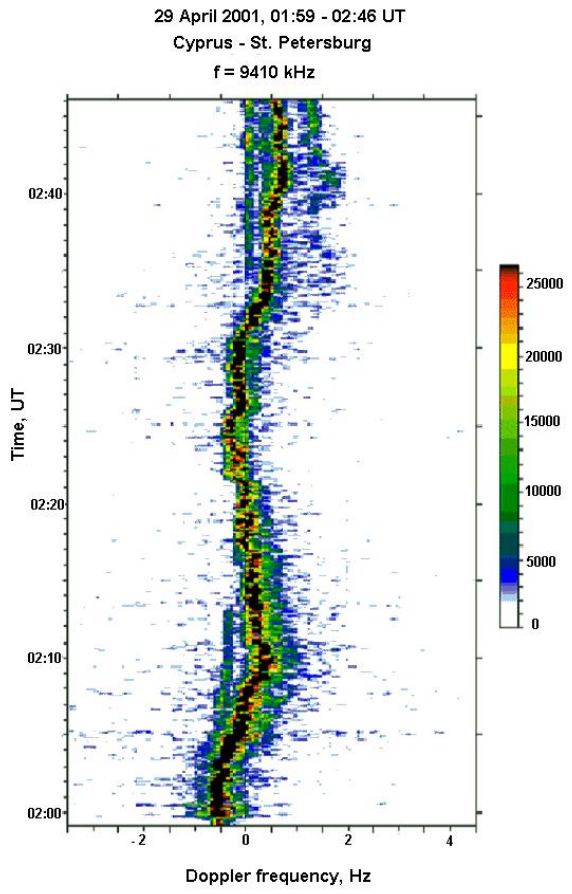
Fig. 9. Sonogram for Cyprus-St. Petersburg between 02:00 and 02:46 UT on 29 April 2001. Numbers on the colour scale are power spectrum values, arbitrary